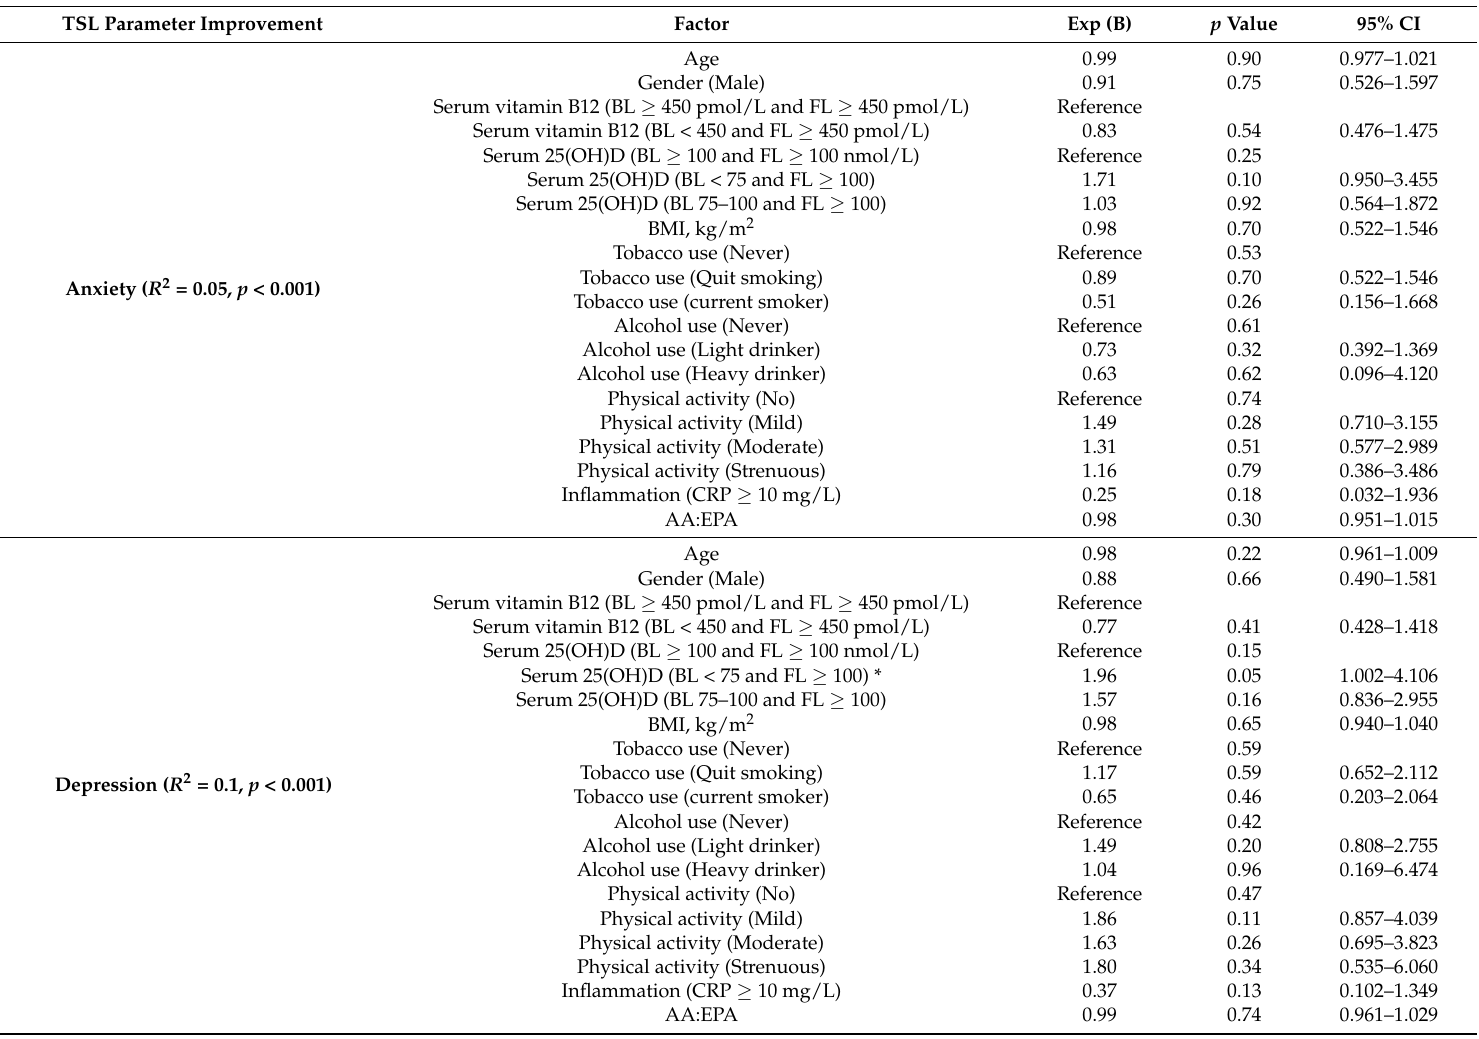
Table 9. Binary Logistic Regression of influencing factors on Targeted Symptoms List (TSL) mental parameters over one